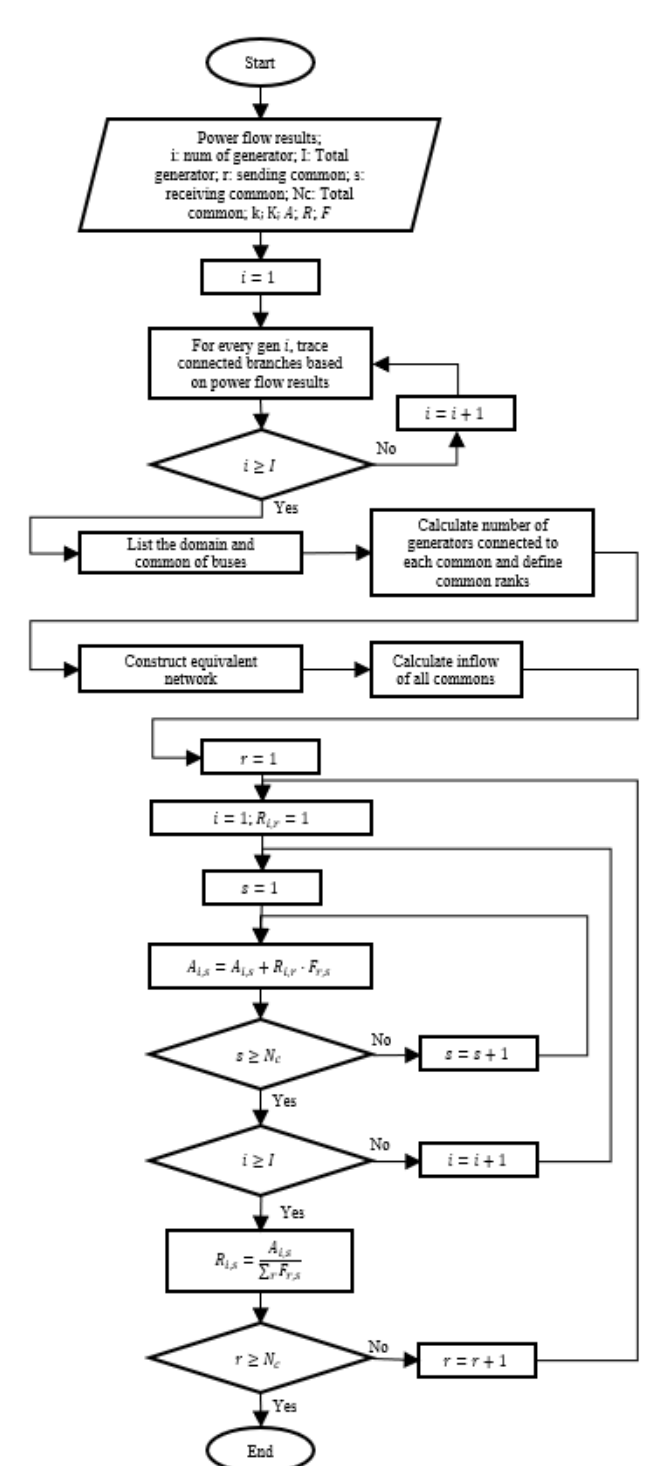
Figure 1. Flowchart of Kirschen’s power tracing method .